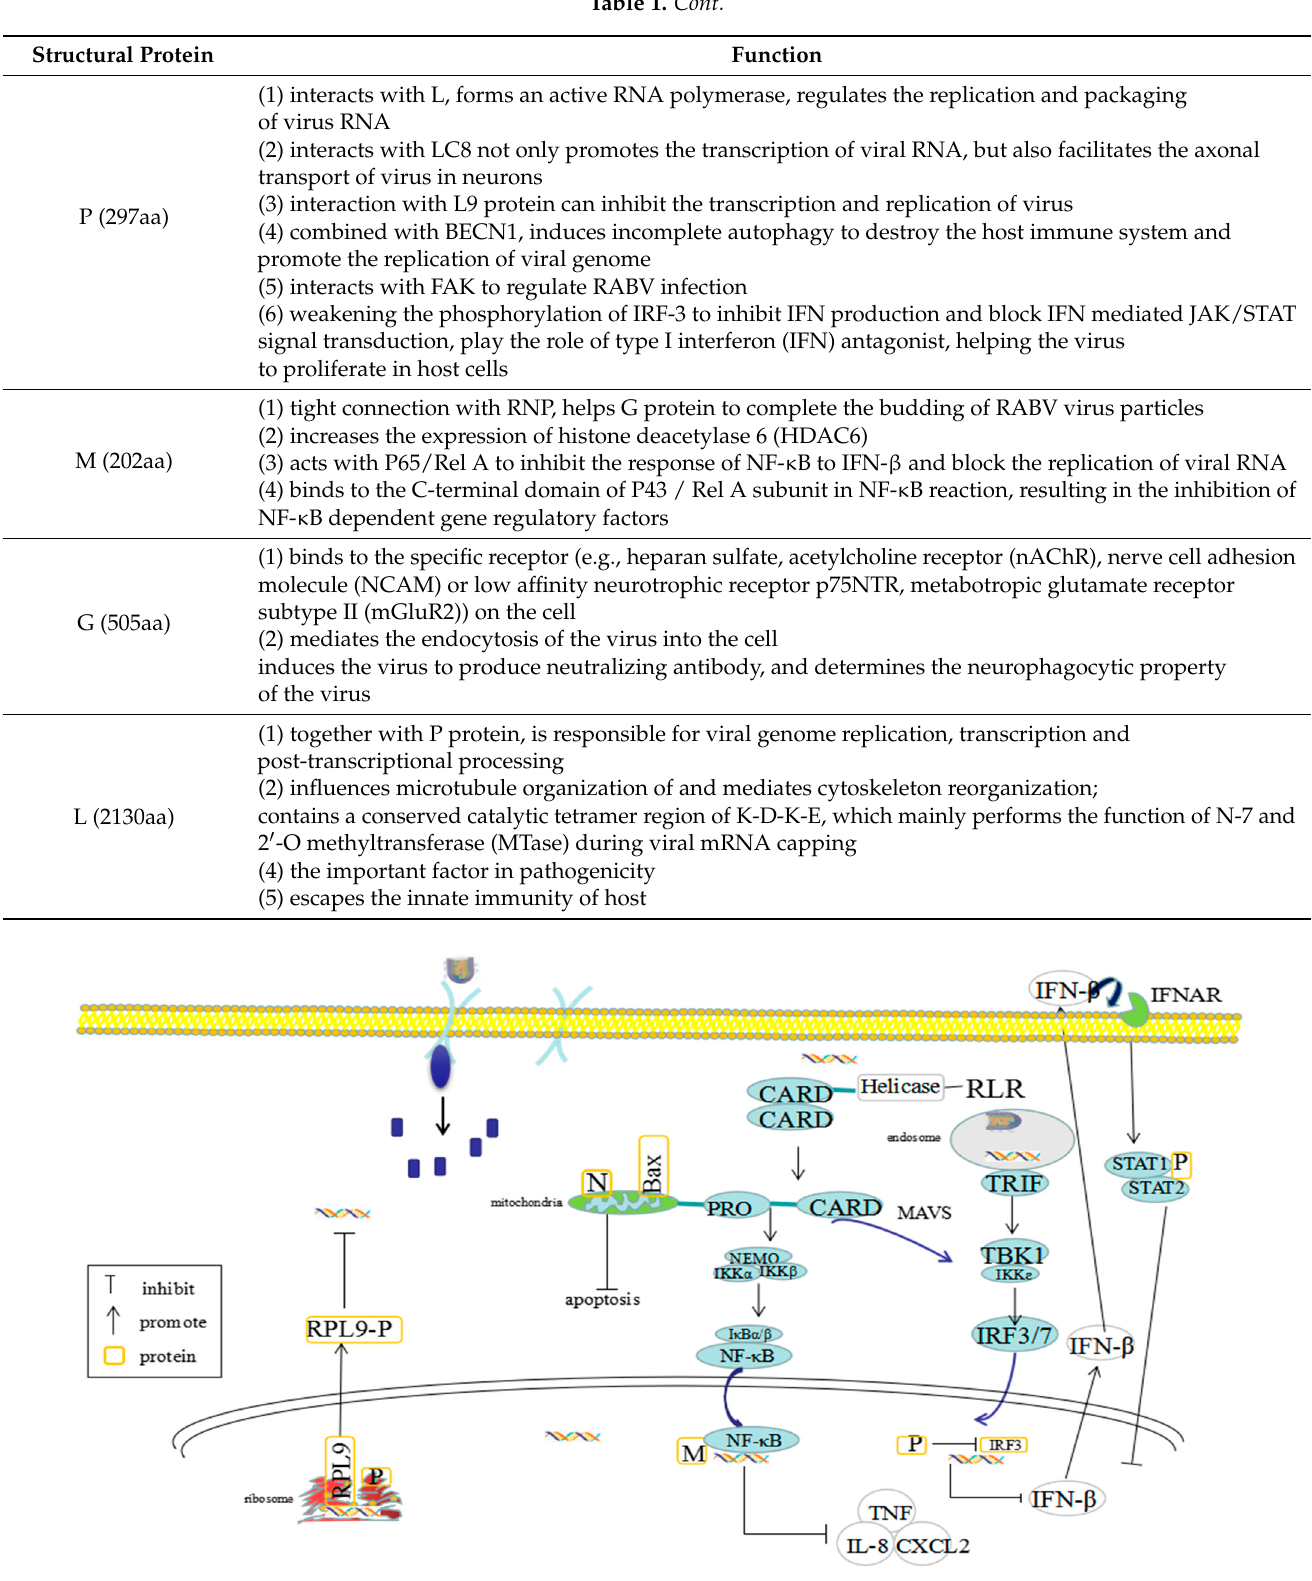
Figure 3. Schematic representation showing the interaction between rabies virus (RABV) viral proteins and host proteins in the innate immune system. N protein and activated Bax protein (a member of Bcl-2 family) co-located in the mitochondria of infected cells, and prevented the activation of Bax. In the early stage of infection, N protein effectively inhibited the apoptosis of mitochondria, prevented caspase-dependent and caspase-independent apoptosis, and provided time for vi- rus replication and transcription. However, the expression of N protein had no effect on the expression level of Bcl-2 family members P protein plays the role of type I interferon (IFN) antagonist by reducing the phosphorylation of IFN regulatory factor-3 (IRF-3), inhibiting IFN production and blocking JAK/STAT signal transduction mediated by IFN. It plays an im- portant role in virus escape from host innate immunity. P protein can bind to RPL9 protein directly in vivo and abroad, and transfer RPL9 protein from nucleus to cytoplasm, thus inhibiting the initial stage of RABV transcription. In the late stage of infection, M protein partially acts on mitochondria through caspase-dependent and caspase-independent path- ways to induce mitochondrial apoptosis and promote virus replication and transmission. The interaction of M protein with C-terminal specific region of RelAP43, one of six members of NF- κ B family, can inhibit NF- κ B signaling and IFN- β transcription, which provides a way to avoid antiviral natural immunity. G protein can bind to cell receptor and mediate the invasion of virus to host, so G protein is closely related to the pathogenicity of virus. Table 1. Virus–Host Interactions in Rabies Virus Infection. Structural Protein